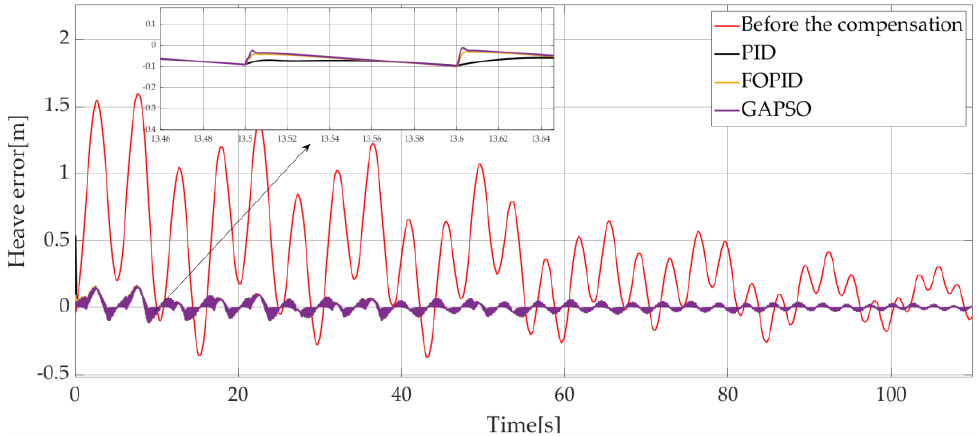
Figure 21. L = 27 m, V = − 0.2 m/s Position of the load with compensation with the 3 studied methods.